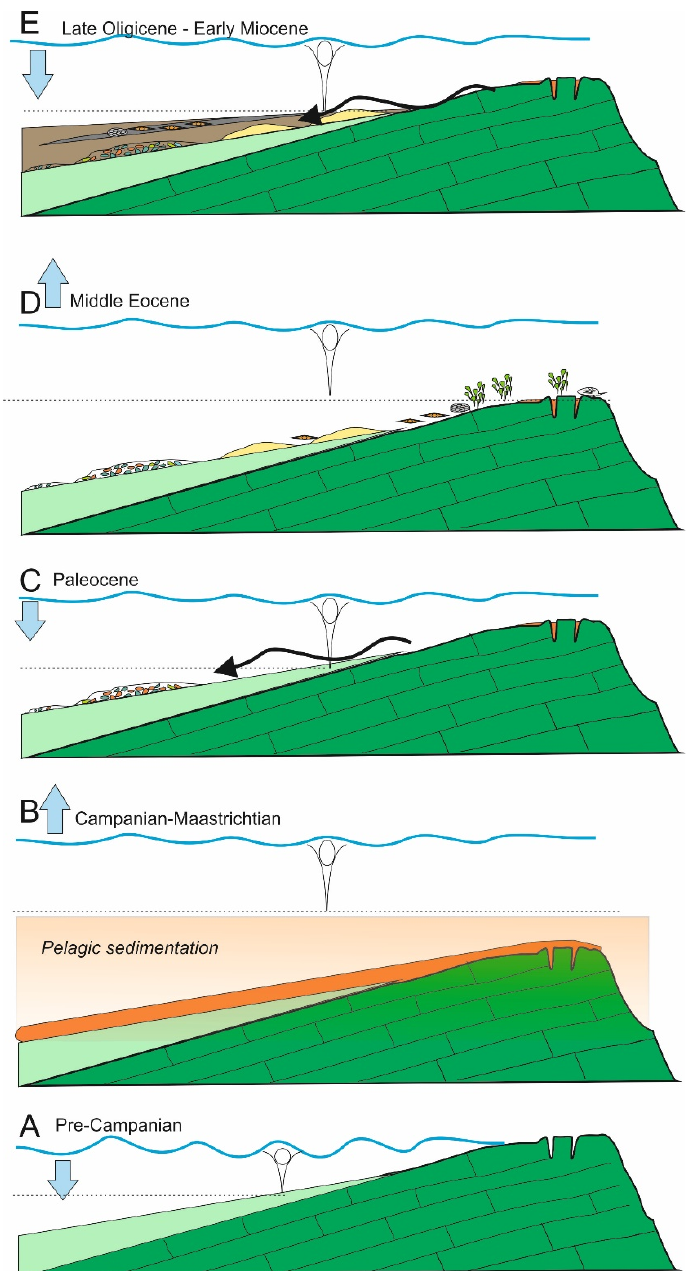
Figure 10. ( A ) Schematic reconstruction of the South Western Prenestini fault-block platform. After a phase of subaerial exposure, the eastern-most sector of the fault-block platform was a shaved platform exposed to the wave action. ( B , D ) The sedimentation on the platform took place during transgressive and sea-level highstand phases, ( C , E ) whereas in the following lowstand, sediment was eroded as the seafloor came into the zone of wave abrasion. These sediments were shed into the western side of the fault block platform to form detrital intercalations.